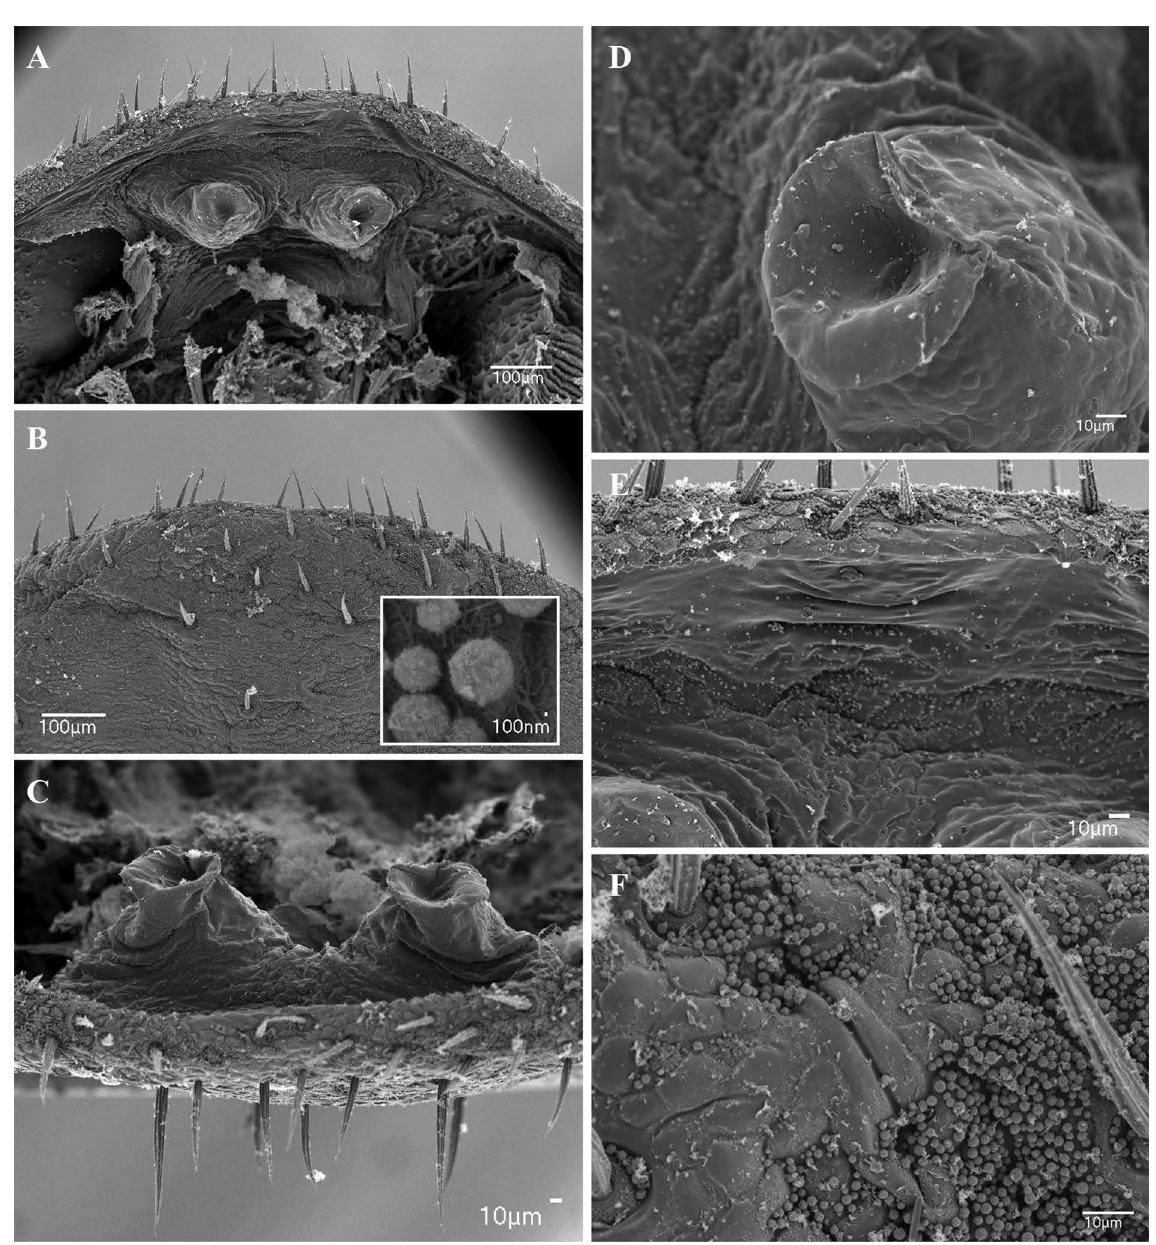
Fig. 77. Charinus souzai sp. nov. (MNRJ 9245), female gonopod and genital operculum. A . Sucker-like gonopod, dorsal view. B . Genital operculum, ventral view. Inset: cerotegument. C . Gonopods, posterior view. D . Aperture on sinistral side of sucker-like gonopod, dorsal view. E . Posterior margin of genital operculum. F . Gland opening near lateral margin of